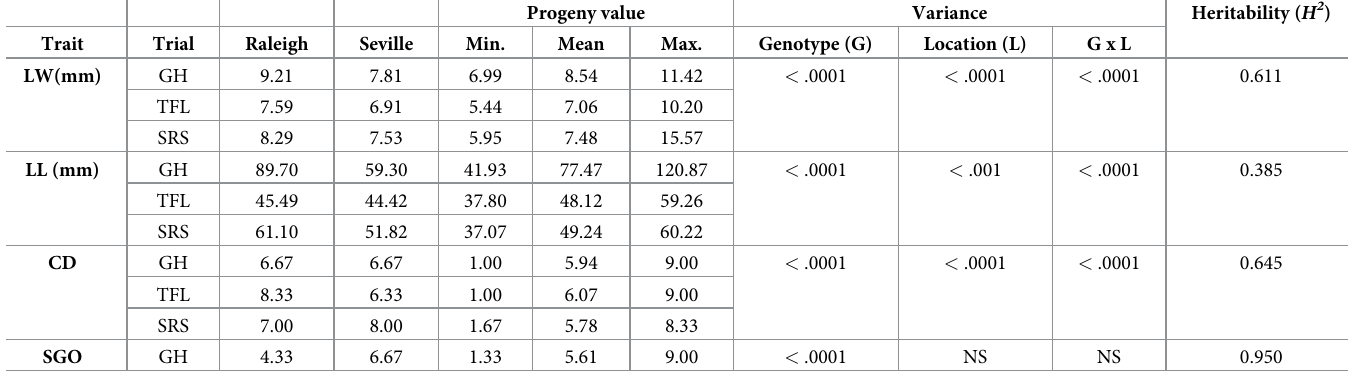
Table 1. Phenotypic data and variance components for leaf width (LW), leaf length (LL), canopy density (CD) and shoot growth orientation (SGO) for a St. Augustinegrass Raleigh x Seville F 1 population evaluated in greenhouse (GH) and field (Lake Wheeler Turf Field Laboratory, TFL and Sandhills Research Sta- tion, SRS)